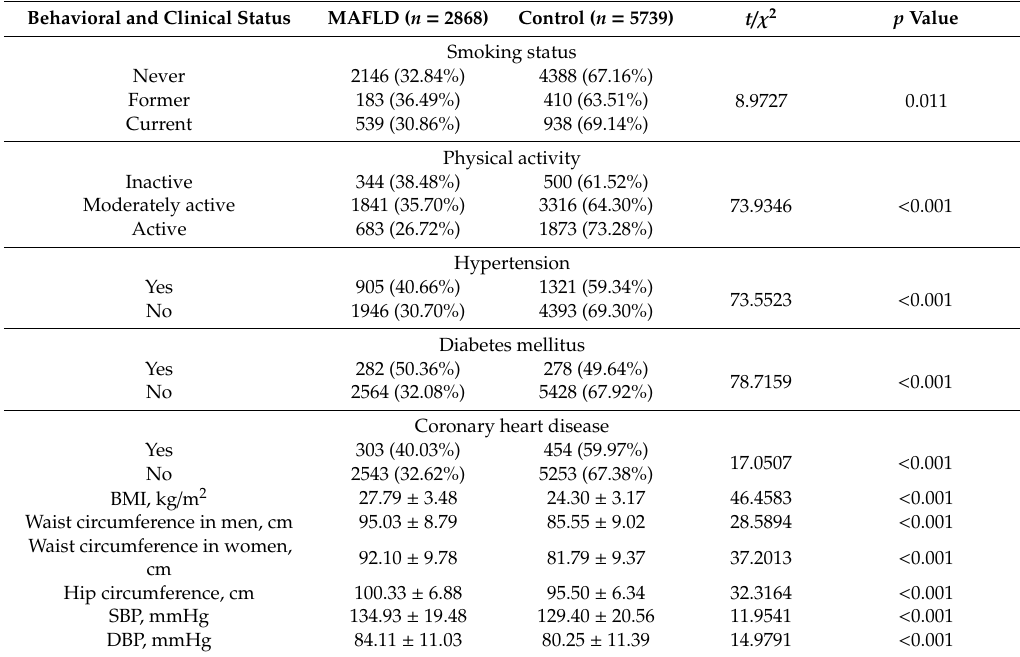
Table 2. Comparison of the behavioral factors and physical examination data between the participants with and without